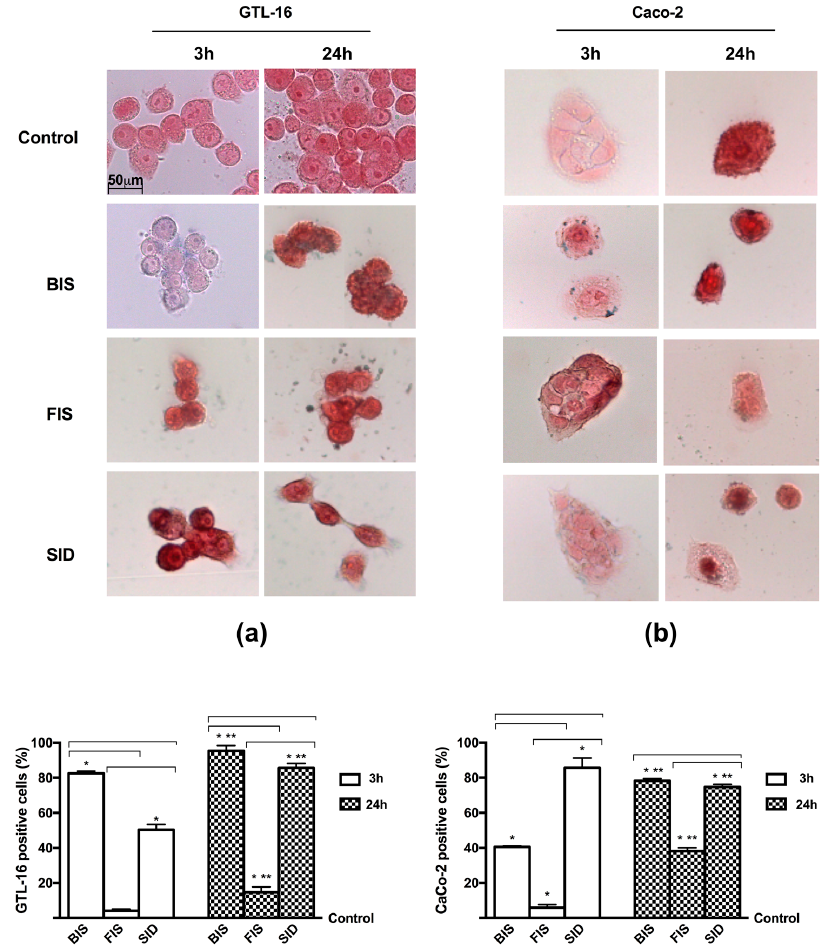
Figure A1. Perl’s staining on GTL-16 ( a ) and Caco-2 ( b ) cells treated with different iron formulations at 3 h and 24 h. ( top ) the images show an example of four independent experiments taken at original magnification 40×. The scale bar in the first image can be used for all others; ( bottom ) the positive cells counted were obtained from four independent experiments and expressed as means ± SD (% vs. control). * p < 0.05 vs. control; ** p < 0.05 vs. correspondent column at different times; bars p < 0.05 among different treatments at the same